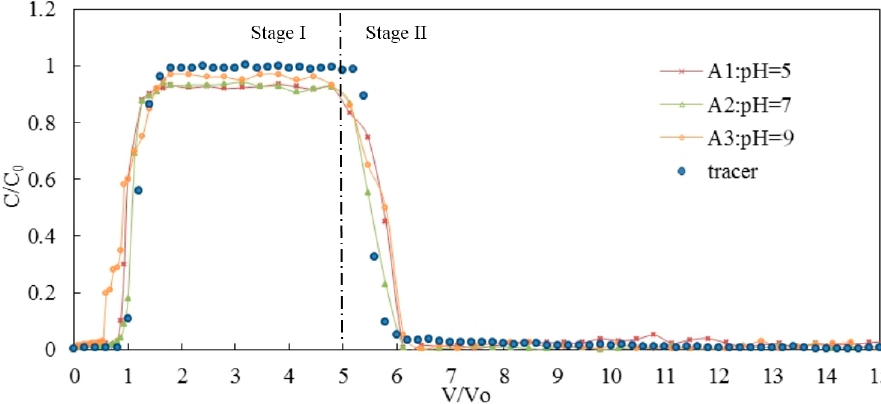
Figure 3. Breakthrough curves of silica colloid suspension under different pH values.